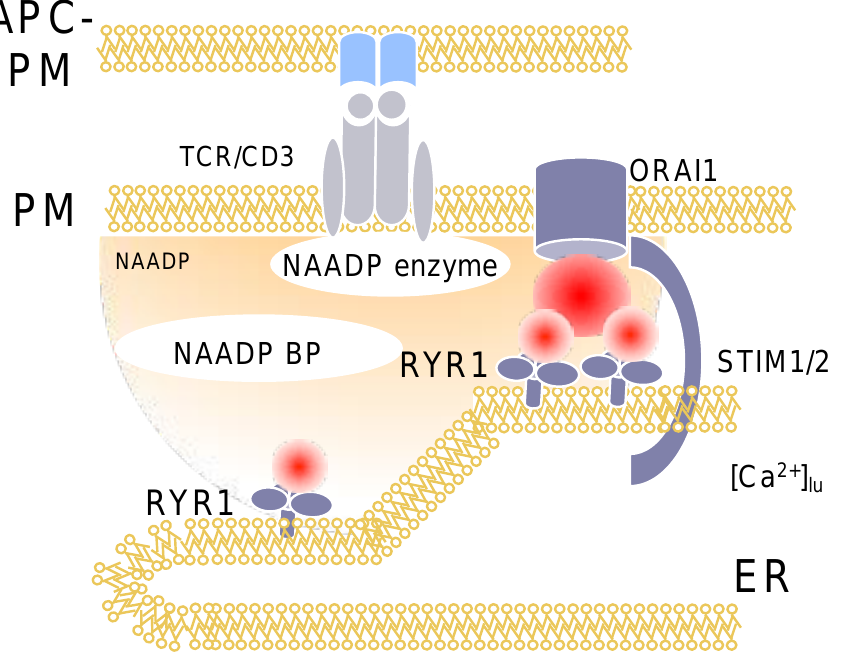
Figure 2. Ca 2+ signaling in the first 15 s of T cell activation: NAADP-dependent Ca 2+ microdomains. Figure 2. Ca 2 + signaling in the first 15 s of T cell activation: NAADP-dependent Ca 2 +